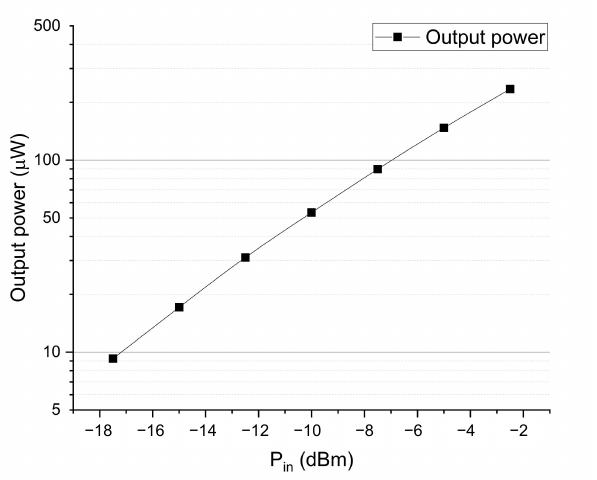
Figure 19. Output power of proposed RF energy harvesting circuits.